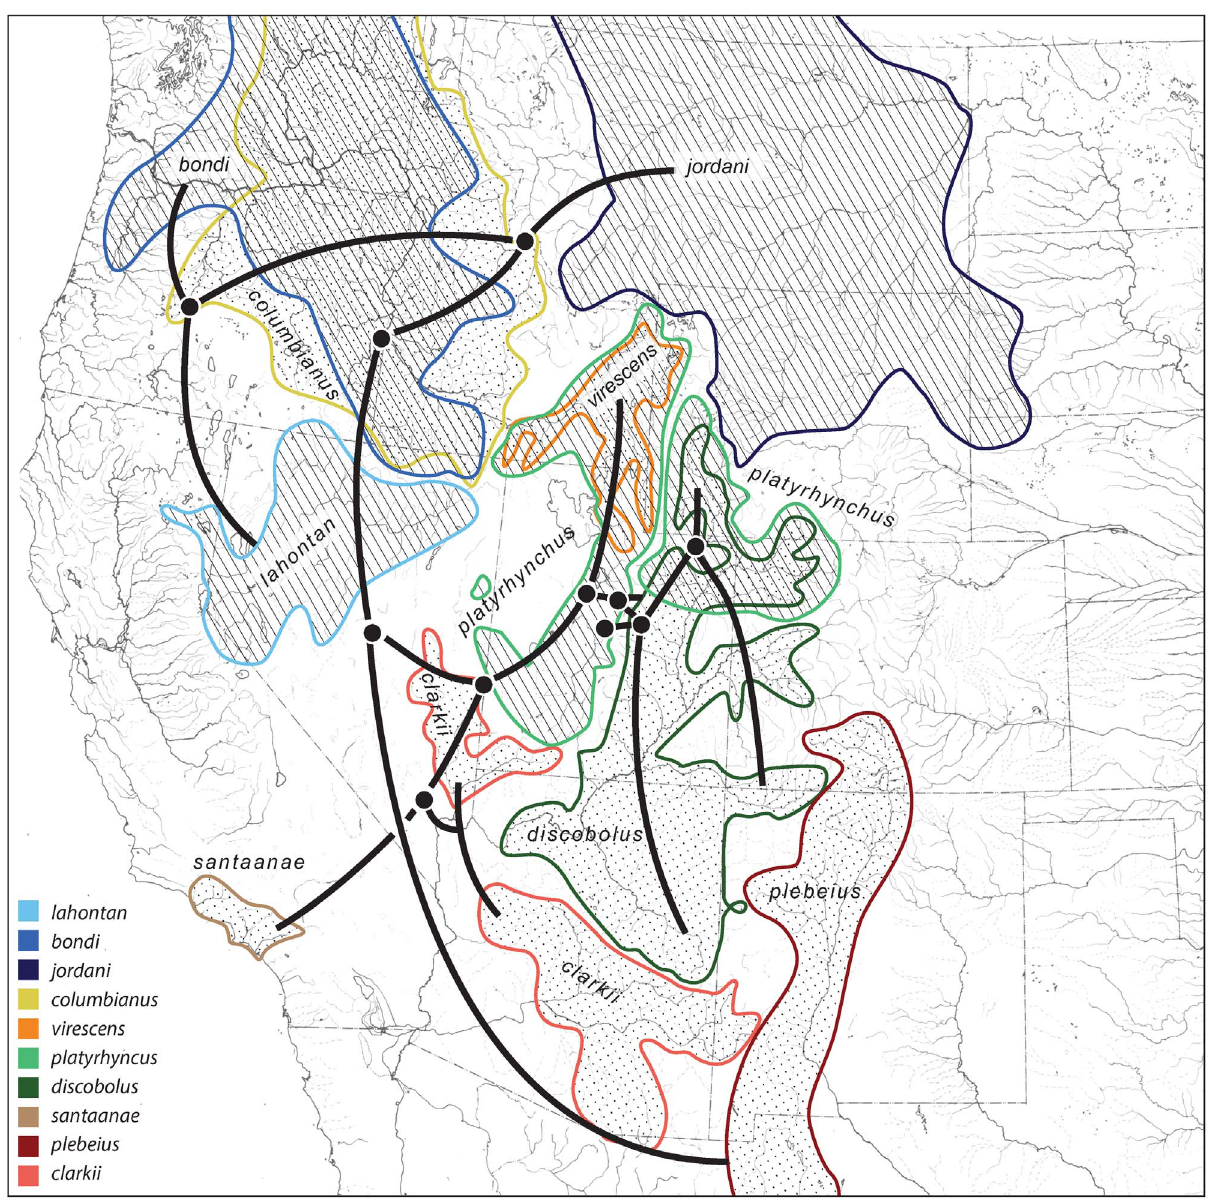
Figure 6. Pantosteus species distribution patterns with overlay of the species relationships from Fig. 5. Estimated ages of branching events are in Fig.